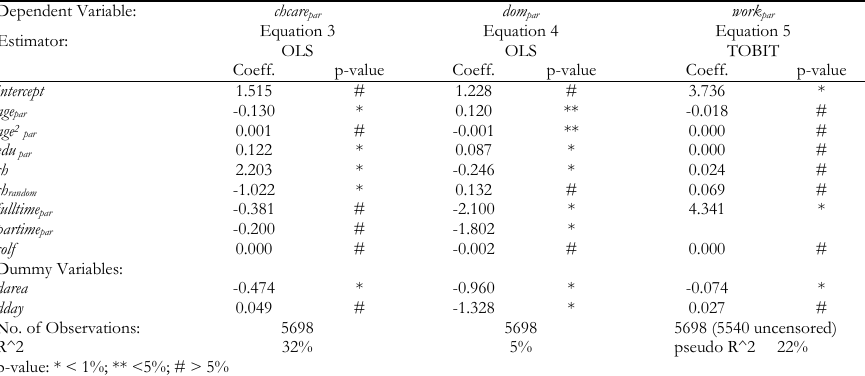
Parametric estimation of partner working activities (paid-work, domestic work and childcare) Dependent